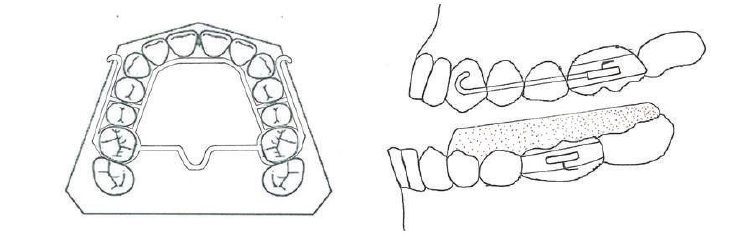
Figure 4: Tandem appliance.